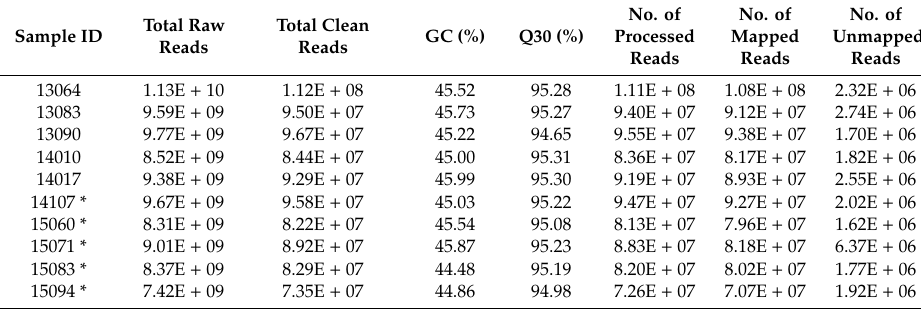
Table 1. Summary of the mapping information for each